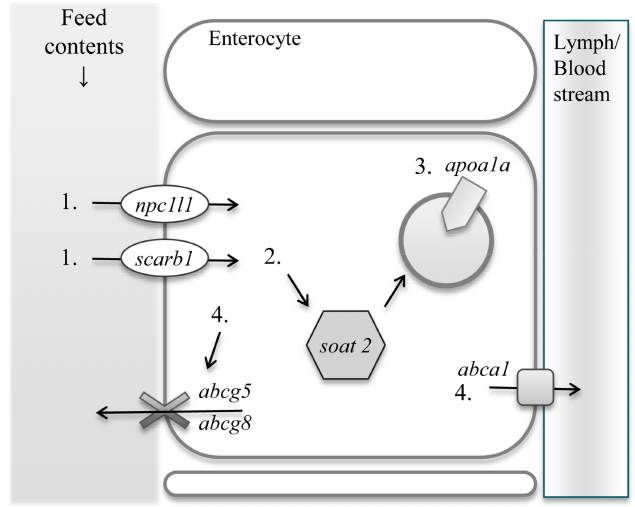
Figure 1. Diagram of sterol uptake and excretion genes. Sterols enter the small intestinal epithelial cells via Niemann-Pick C1-like protein 1 (1. npc1l1 ) and scavenger receptor class B, member 1 (1. scarb1 ) and esterified with fatty acid by O-acyltransferase 2 (2. soat2 ). Esterified sterols are encapsulated with Apolipoprotein A-I (3. apoa1a ). Excessive sterols are excreted via ATP-binding cassette sub-family G, member 5 and 8 (4. abcg5 / abcg8 ) and ATP-binding cassette, sub-family A, member 1 (4. abca1 ). Nomenclature in the parentheses represent gene name. Lipoprotein particles are excreted from intestinal epithelial cells to lymph in mammals, whereas to portal vein in